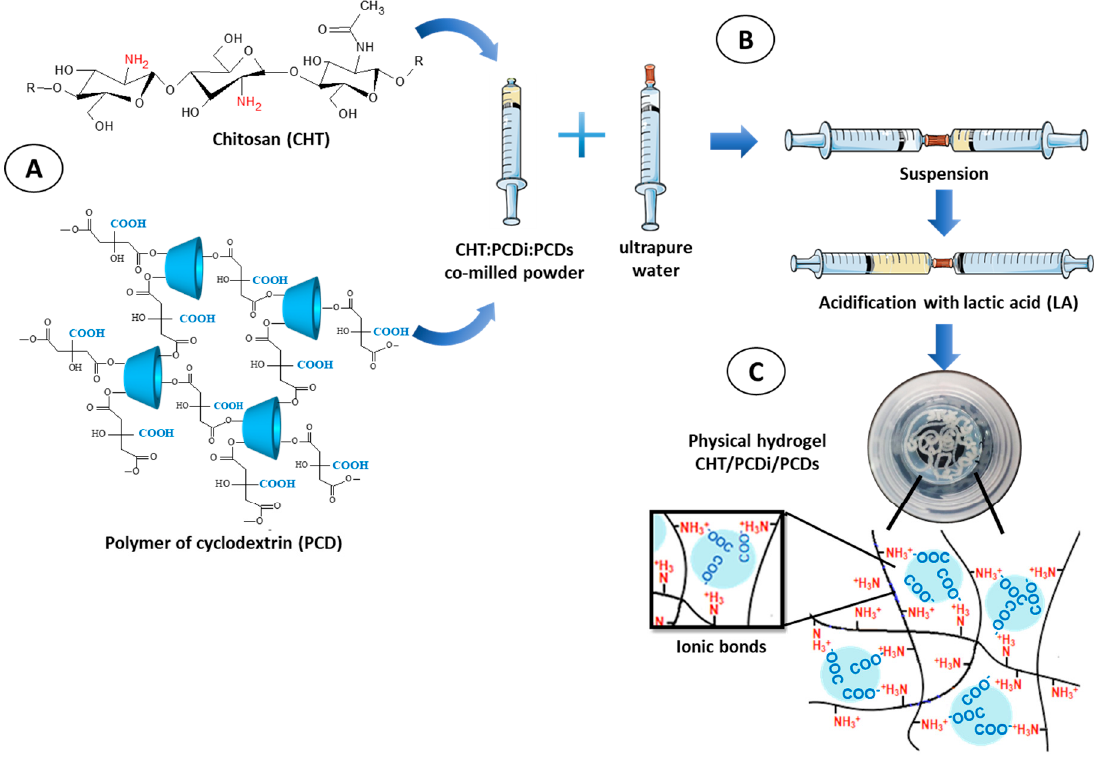
Figure 1. Schematic representation of the formation of CHT/PCDi/PCDs hydrogels. ( A ) The chemical structure of CHT and PCD, i.e., the co-milled powders loaded in one of the syringes; ( B ) the double-syringe system used for the preparation of hydrogel: The suspension phase, followed by the acidification to generate the PEC; ( C ) the macroscopic appearance of an injected CHT/PCDi/PCDs physical hydrogel (at a ratio of 3:1.5:1.5).